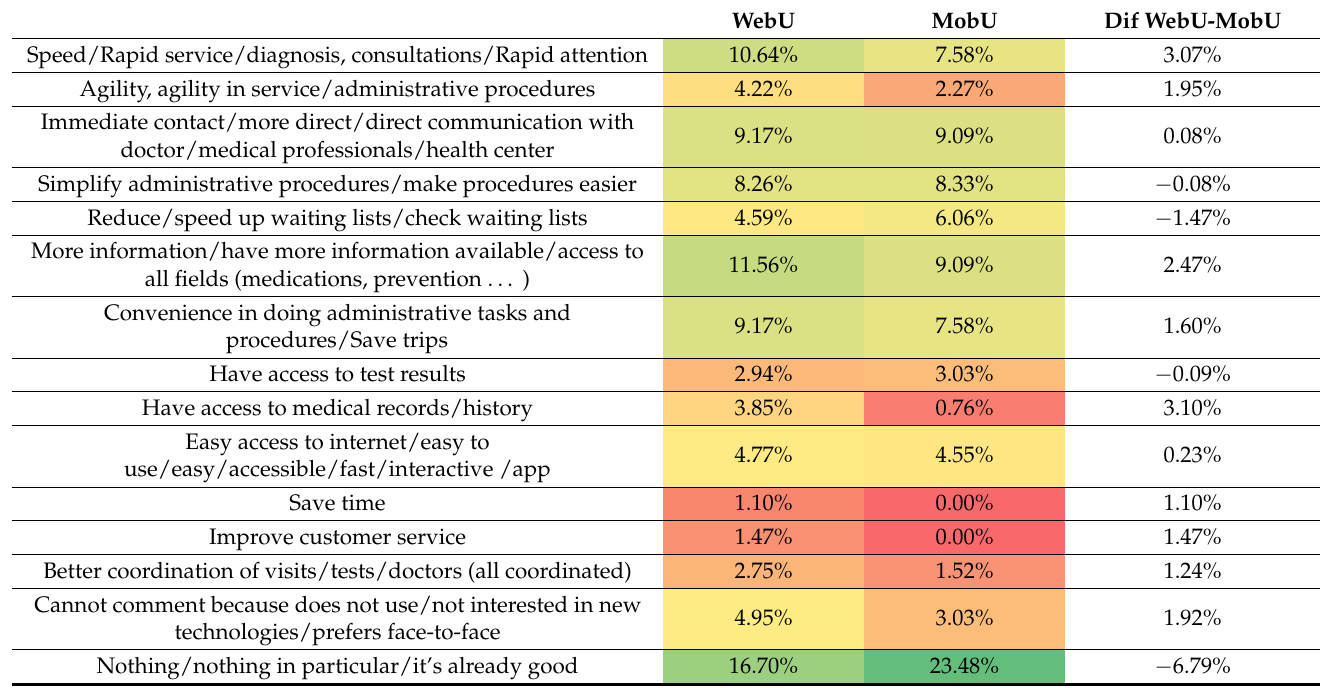
Table 5. Actions that could improve the impact of ICTs on health services (by user